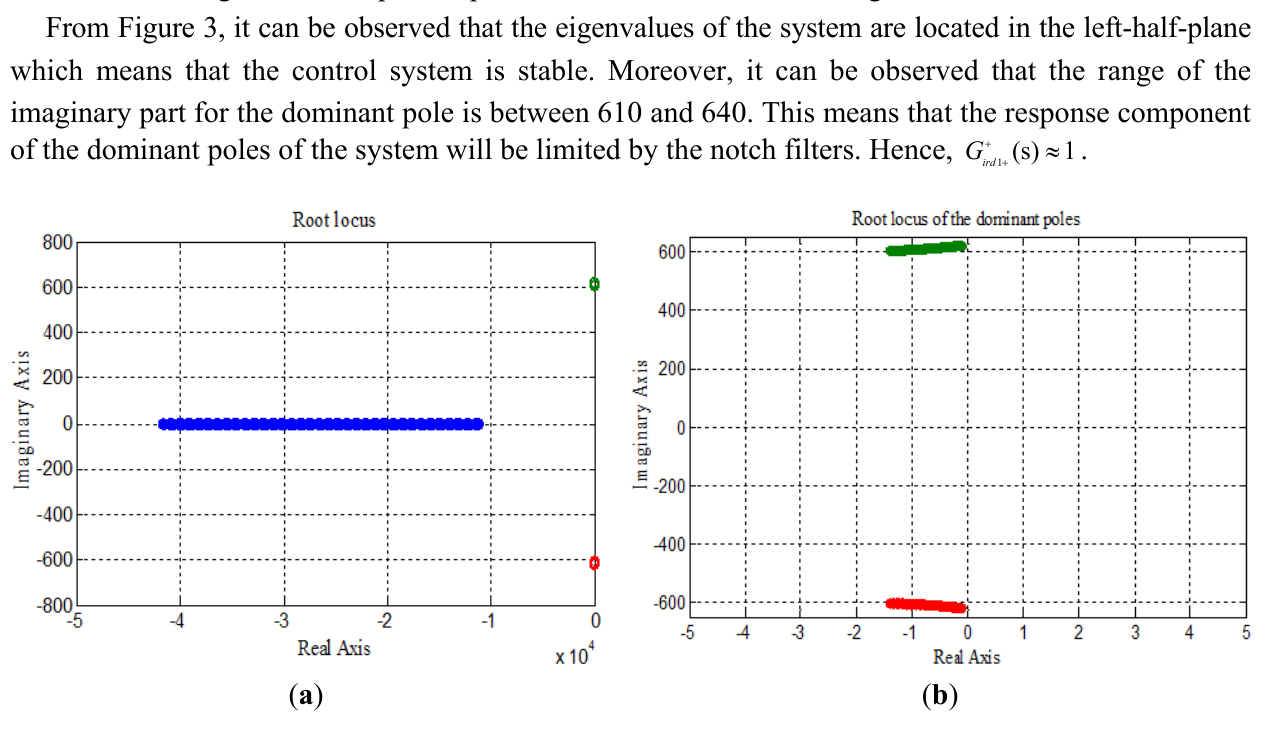
Figure 3. Root locus diagram of the open-loop transfer function. ( a ) root locus with